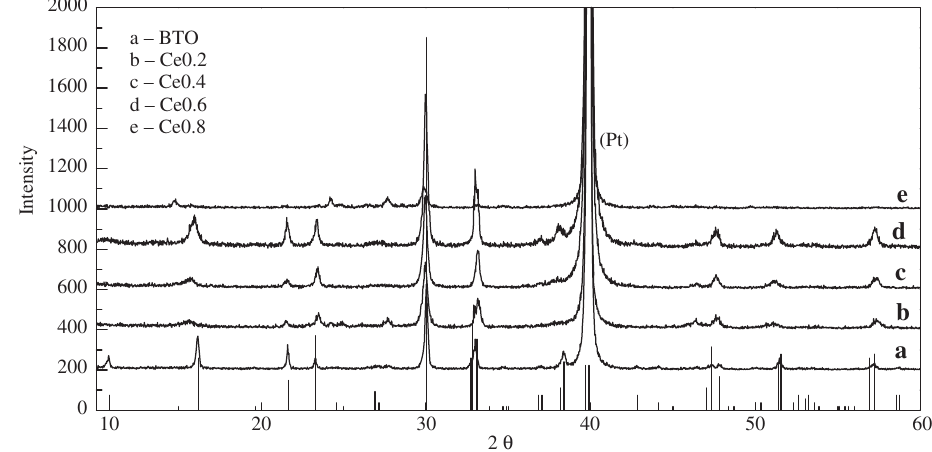
/SiO /Si annealed at 700 ° C. 2 2